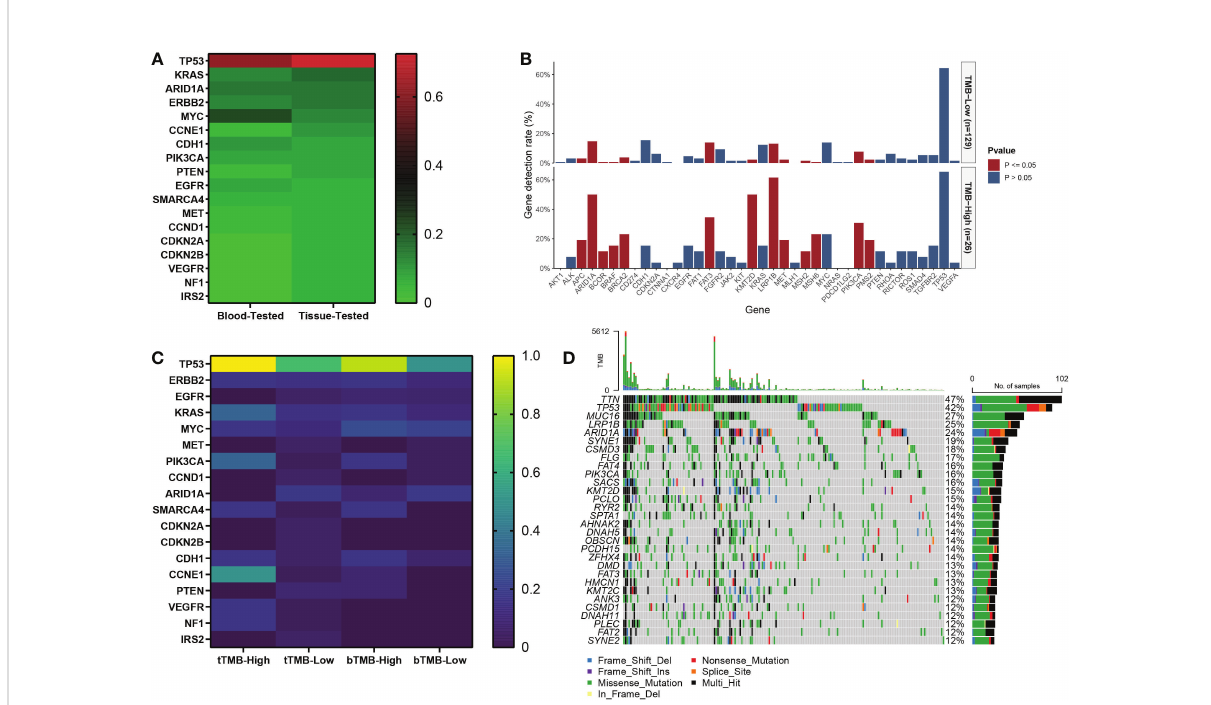
FIGURE 2 The gene mutation spectrum of patients with advanced gastric cancer in our cohort. (A) The mutation frequency of tissue-tested and blood- tested samples of 18 genes with mutation frequency equal to or higher than 5% in 40 patients receiving fi rst-line chemotherapy. (B) The association between TMB status and gene mutation in 155 patients. (C) The gene mutation frequency heatmap according to TMB status of tissue and blood samples in 40 patients. (D) Waterfall of gene mutations in the TCGA